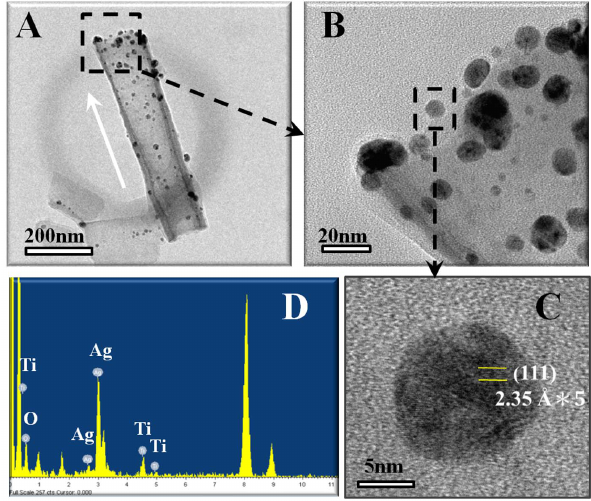
Figure 2. TEM analysis results of an Ag-decorated TiO 2 nanotube. ( A ) TEM image taken from an Ag-decorated TiO 2 nanotube with the diameter of 100 nm. ( B , C ) High-magnification views of the selected regions, and ( D ) the corresponding EDS spectrum. The white arrow in ( A ) indicates the growth direction of the TiO 2 nanotube.